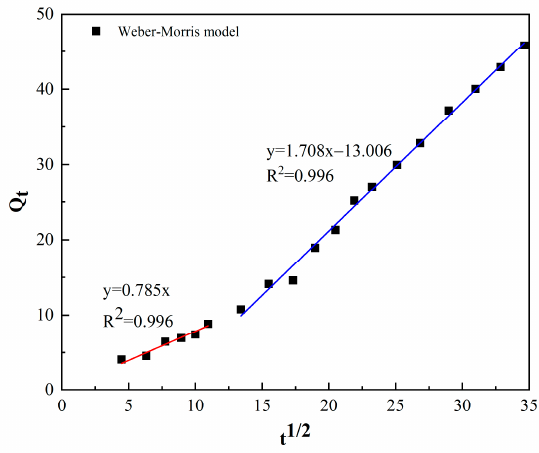
Figure 13. Weber–Morris model two-stage curve fitting.